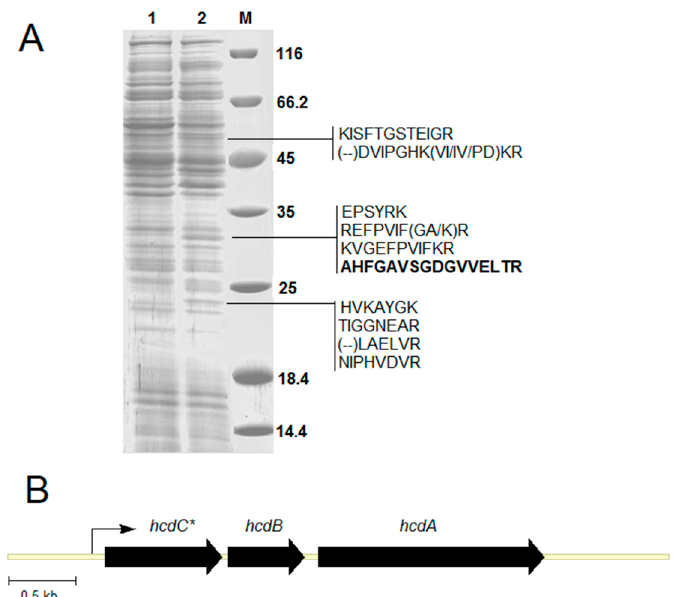
Figure 3. ( A ) SDS-PAGE analysis of cell-free extracts of Pseudomonas sp. 7HK4. Bacteria were cultivated in the presence of glucose (lane 1) or 7-hydroxycoumarin (lane 2). M—molecular mass ladder (kDa). The arrows indicate 7-hydroxycoumarin-inducible 23, 32, and 50 kDa proteins. The peptide sequences determined by MS-MS are given on the right. The sequence in bold was identified after the peptide sequences obtained by MS-MS were compared with the partially sequenced genome of Pseudomonas sp. 7HK4. ( B ) Organization of hcd genes in Pseudomonas sp. 7HK4 bacteria. The arrows indicate open reading frames (ORFs) encoding HcdA, HcdB, and HcdC. The gene for the 7-hydroxycoumarin-inducible protein of 31.2 kDa is marked by an asterisk.